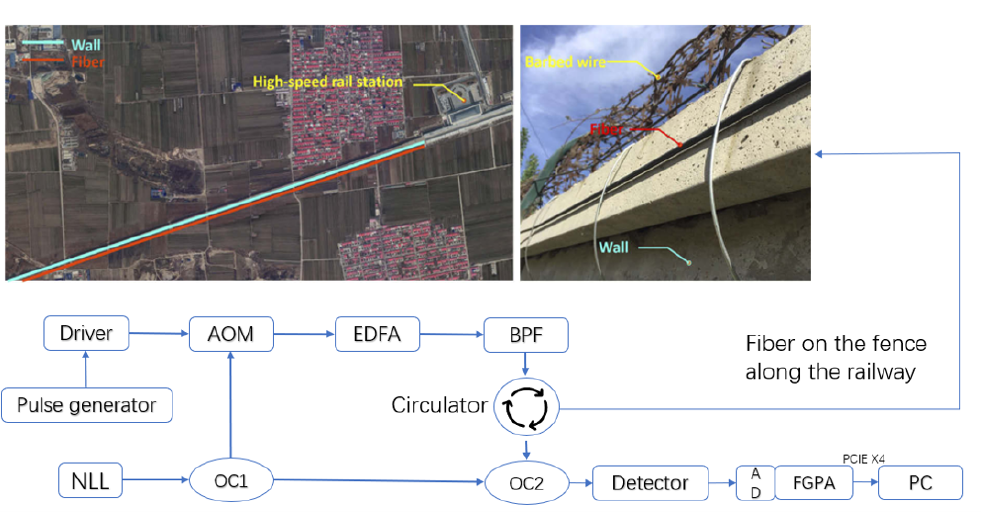
Figure 1. Optical setup of the DAS system.